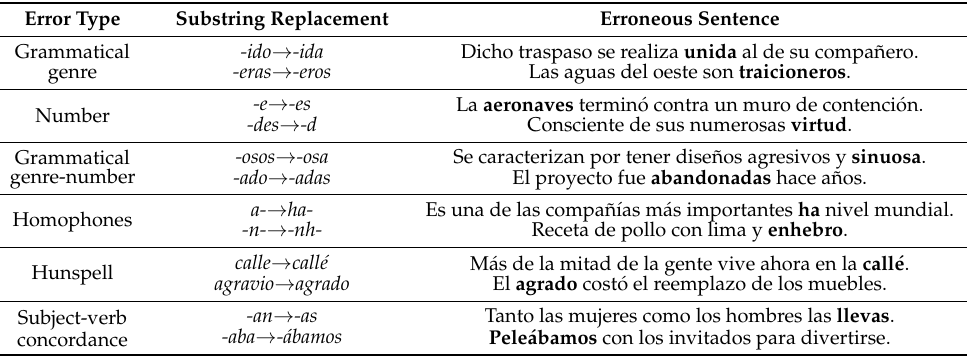
Table 3. Different error types used. Errors were generated by replacing word substrings (in